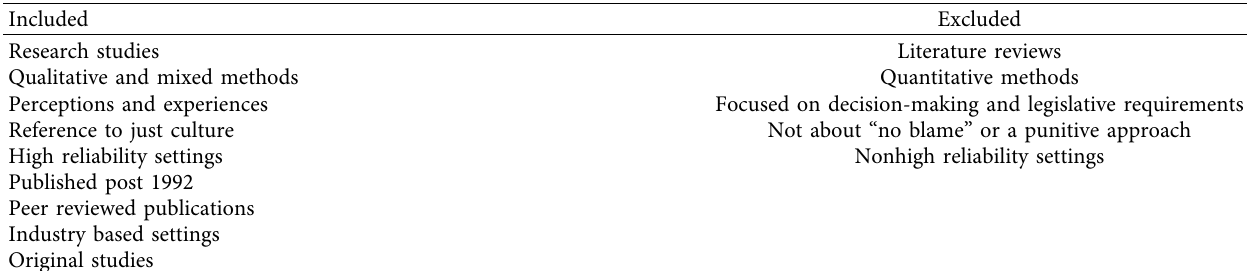
Table 1: Inclusion and exclusion criteria used for the filtering of the subset of primary publications (table adopted from Clare and Kourousis [28]).